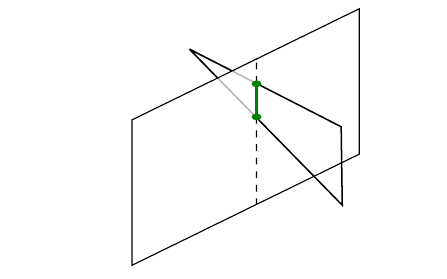
Figure 13: Intersection of polygon 1 with plane of polygon 2